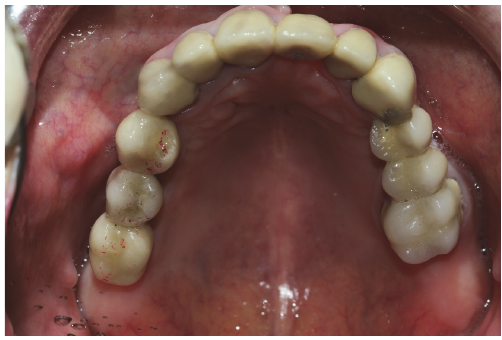
Figure 6: Dental impression.